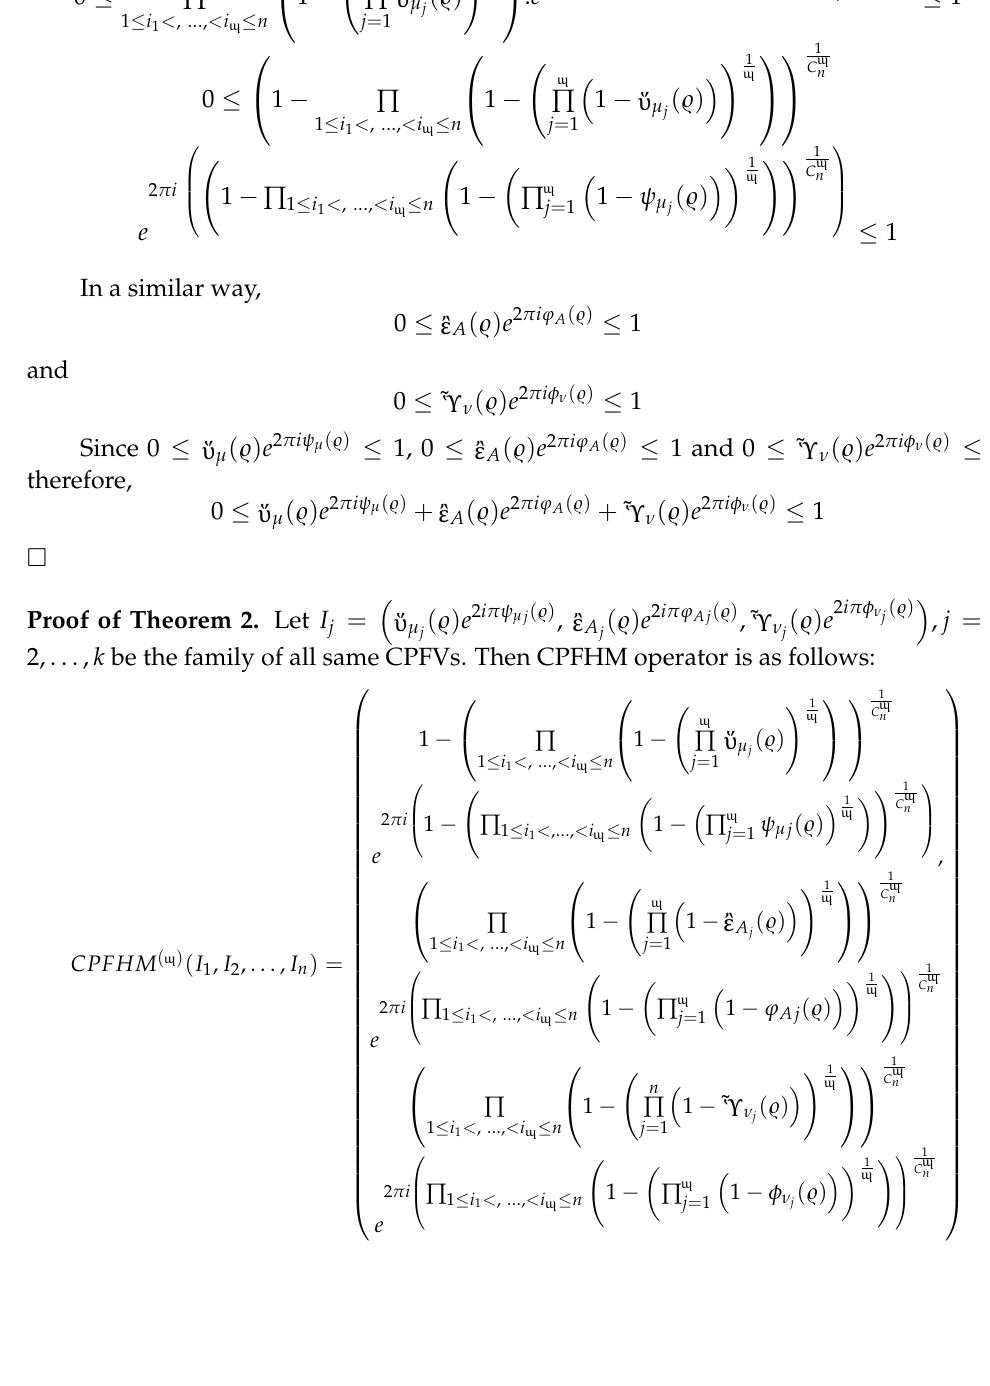
Table 1. Symbols and their